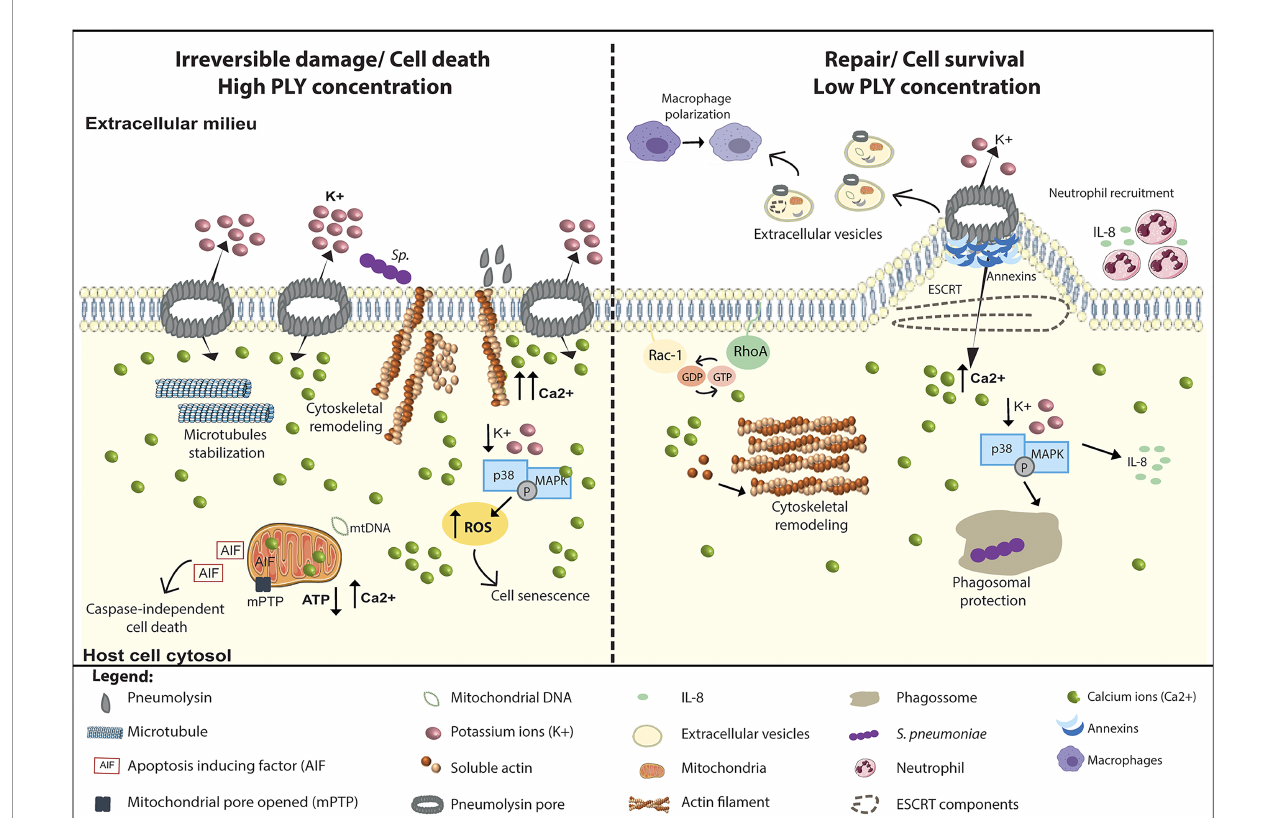
increase in intracellular Ca 2+ levels induces the surface exposure of actin which facilitate Sp adhesion and invasion, increasing cell death. In addition, PLY-mediated microtubule stabilization may perturb axonal transport, likely contributing neuronal damage. Also, in neuronal cells, p38/MAPK activation is detrimental for the host cell as it increases ROS production and induces senescence. High PLY concentrations cause irreversible mitochondrial damage by inducing swelling, loss of mitochondrial membrane potential, and morphologic and metabolic alterations. Concomitantly with Ca 2+ overload, mitochondrial permeability increases, the ATP levels decrease, and mitochondrial DNA is released into the cytosol. Following these events, the mitochondrial apoptosis-induced factor (AIF) reaches the cytoplasm and activates caspase-independent cell death. Right Panel: At sub-lytic amounts, the in fl ux of limited amounts of extracellular Ca 2+ triggers the sequential recruitment of annexins to the damaged sites where they assemble in 3D arrays to clog the PM pore. Increased intracellular Ca 2+ also induces cytoskeleton remodeling through the activation of small GTPases Rac1 and RhoA and triggers PM rearrangements culminating in PM blebbing and ESCRT-mediated release of microvesicles containing PLY,